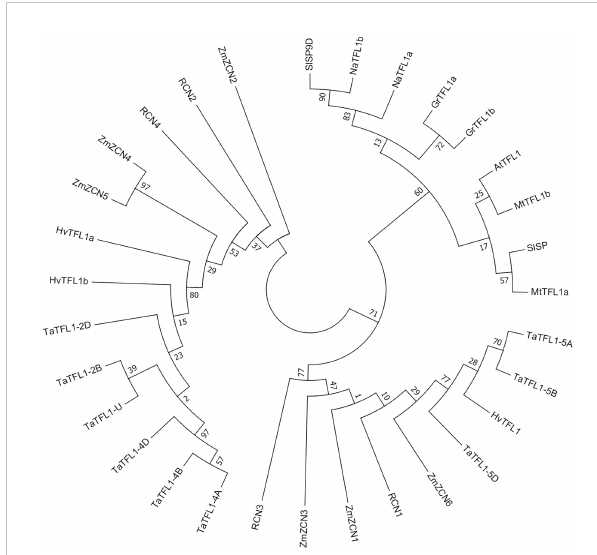
FIGURE 1 Phylogenetic analysis of TFL1 and its homologs in plant species. The rootless phylogenetic tree of TFL1 and its homologs from Hordeum vulgare , Triticum aestivum , Oryza sativa , Zea mays , Solanum lycopersicum , Nicotiana attenuate , Gossypium raimondii and Medicago truncatula was constructed by using MEGA 6.0 (Table